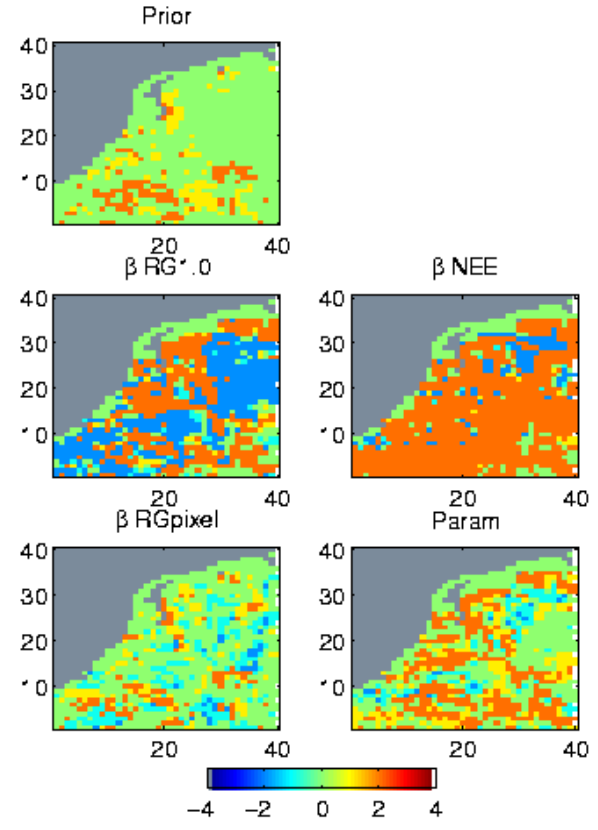
Fig. 6. Spatial maps of the posterior flux residuals (true-minus- optimized fluxes) scaled by the posterior standard deviation of the flux estimate. Green colors indicate that the true flux is within ± 1 standard deviation of the estimated flux, yellow/light blue in dicate within 2 or − 2 standard deviation respectively and orange/blue col- ors are outside this range. The figure shows the general tendency of the inversions to be overconfident, because structural differences between 5PM and FACEM are not taken into account in the treat- ment of